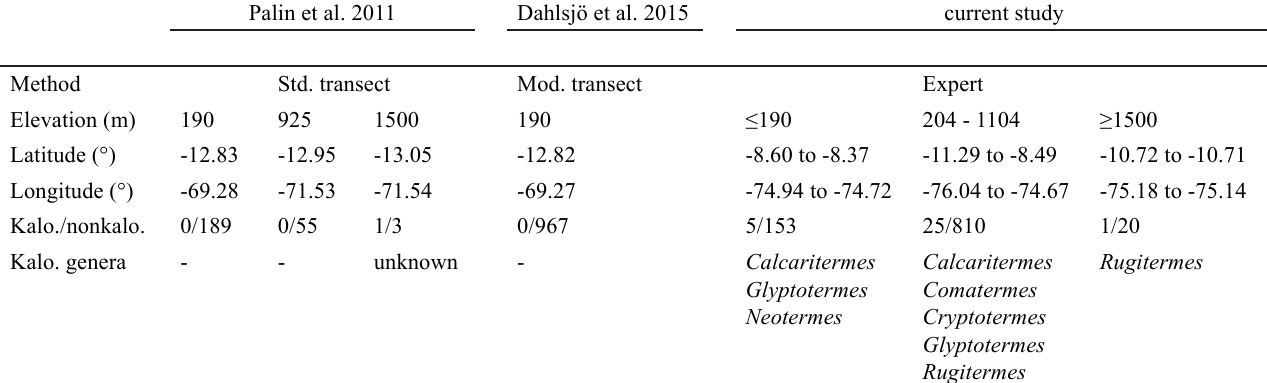
Table 4 . Kalotermitid versus nonkalotermitid sampling yields from three Peruvian Amazon termite